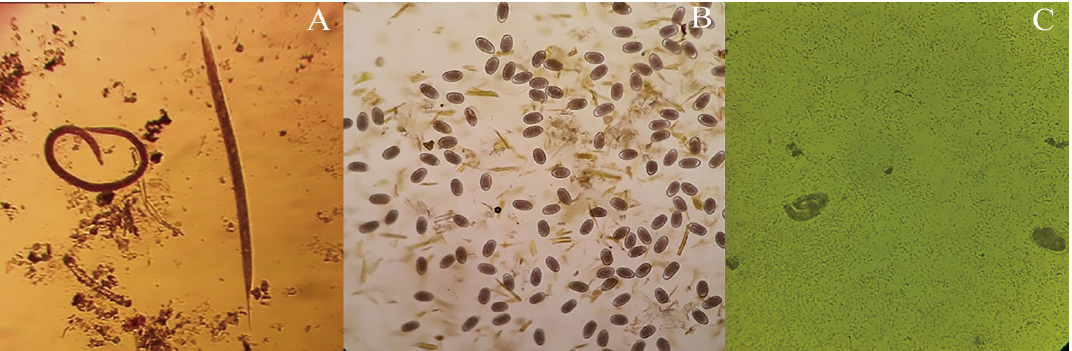
Figure 1. ( A ) Haemonchus contortus larvae with and without cuticle (40×); ( B ) morulae eggs of